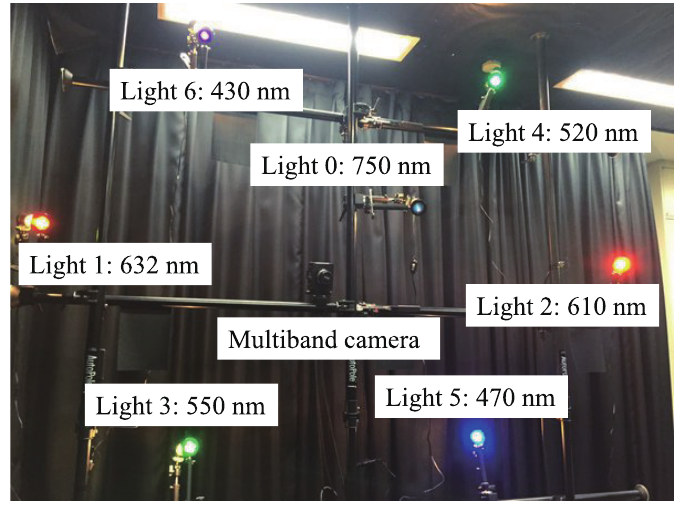
Figure 10. Experimental setup with 7 light sources with different wavelengths and a single 7-band multispectral camera.